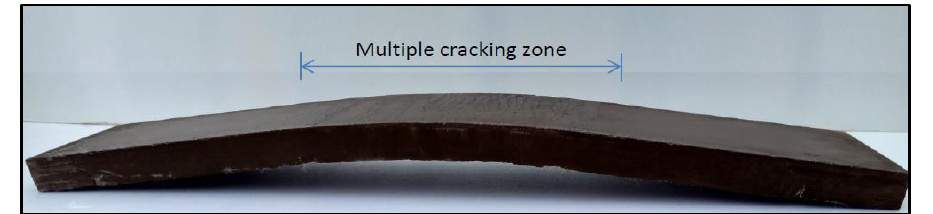
Figure 16. Deflection of EGC with multiple cracking behaviors.